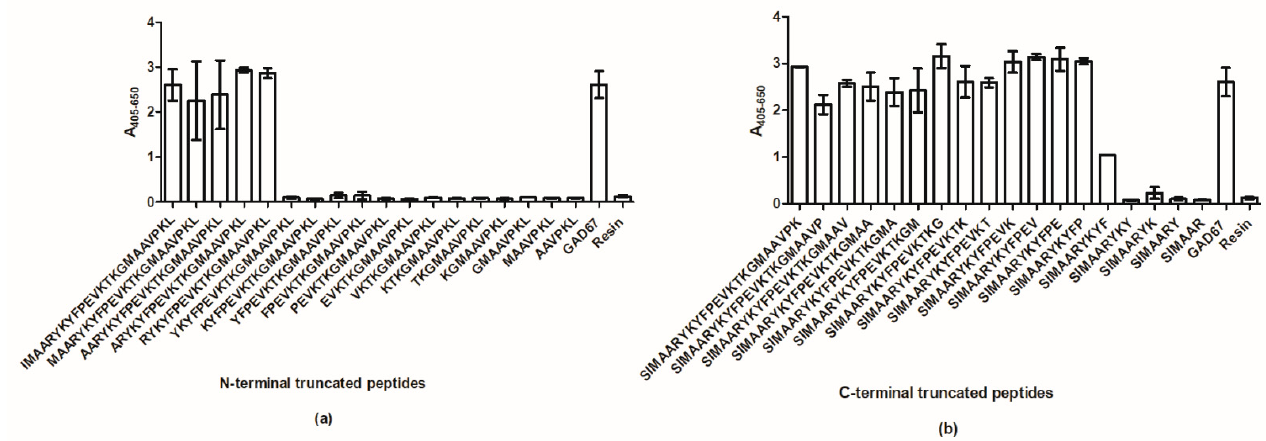
Figure 4. Reactivity of SSI-HYB 387-01 to N- and C-terminal-truncated resin-bound peptides analyzed by modified enzyme-linked immunosorbent assay. ( a ) Reactivity to N-terminal-truncated peptides. ( b ) Reactivity to C-terminal-truncated peptides. Full-length glutamic acid decarboxylase (GAD)67 peptide was used as positive control. Resin was used for background determination.